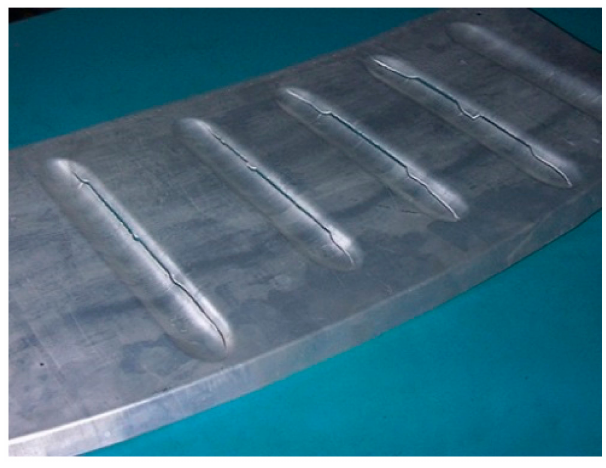
Figure 1. Cracks due to necking in the radius of the stamping